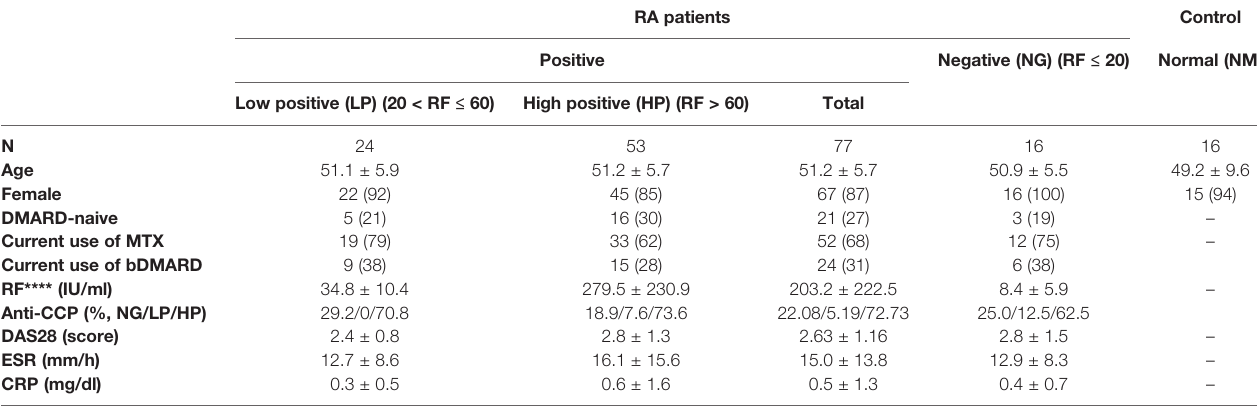
TABLE 1 | Clinical features of research